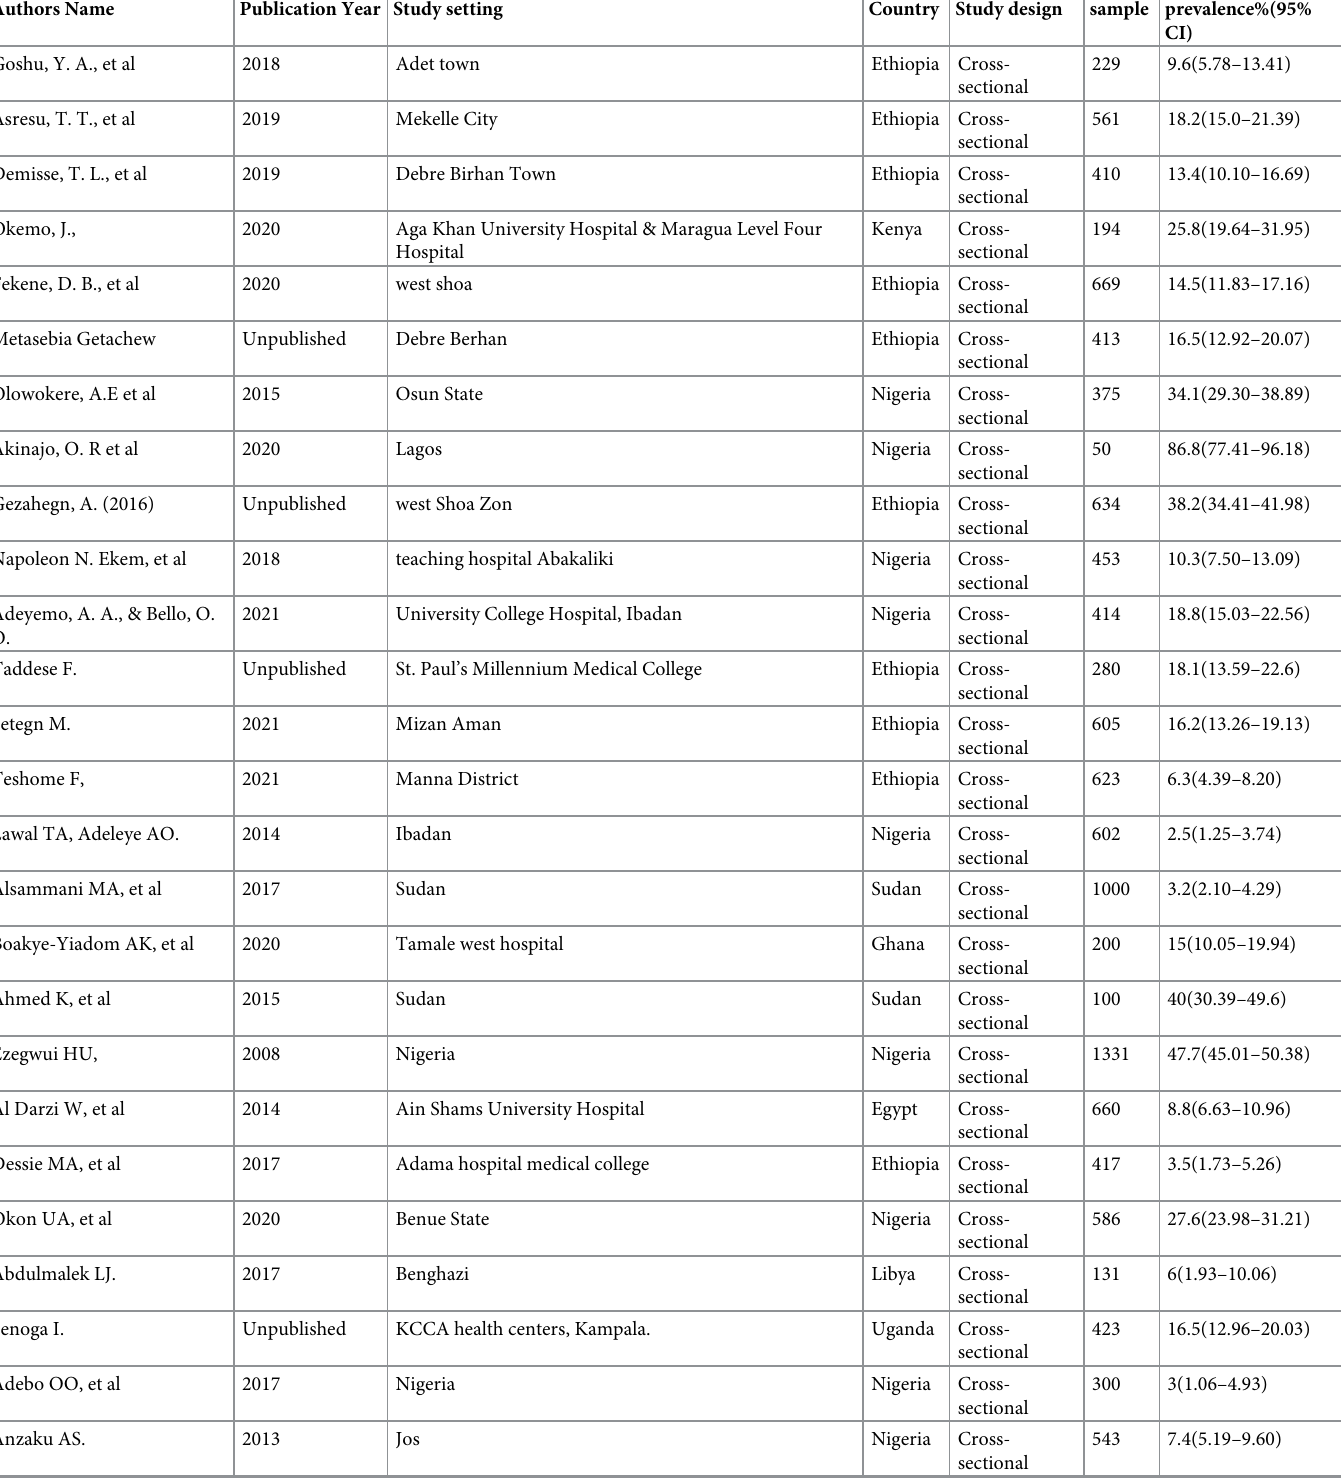
Table 1. Characteristics of the included studies in the systematic review and